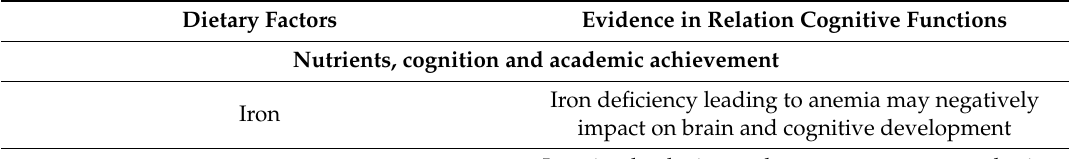
Table 1. Associations of dietary factors with cognition and academic performance. Dietary Factors Evidence in Relation Cognitive Functions Nutrients, cognition and academic achievement Iron deficiency leading to anemia may negatively Iron impact on brain and cognitive development Low intake during early years may attenuate brain Docosahexaenoic acid and eicosapentaenoic acid and cognitive development Foods, cognition and academic achievement A higher consumption of fish has been associated Fish with better cognitive functions A higher consumption of fruit, berries, and vegetables Fruit, berries, and vegetables have been associated with better cognitive functions A higher consumption of fast foods has been Fast foods associated with poorer cognitive functions Dietary patterns, diet quality indices, cognition and academic achievement Dietary patterns high in vegetables, fruits, and home-prepared foods have been associated with better cognitive functions. Dietary patterns Dietary patterns high in fast foods, red meat, soft-drinks, and fried and refined foods have been linked to poorer cognitive functions Diet quality indices (DASH, BSDS, FCHEI, scores) has been associated with better cognitive KIDMEX, HEI-2005) functions and academic